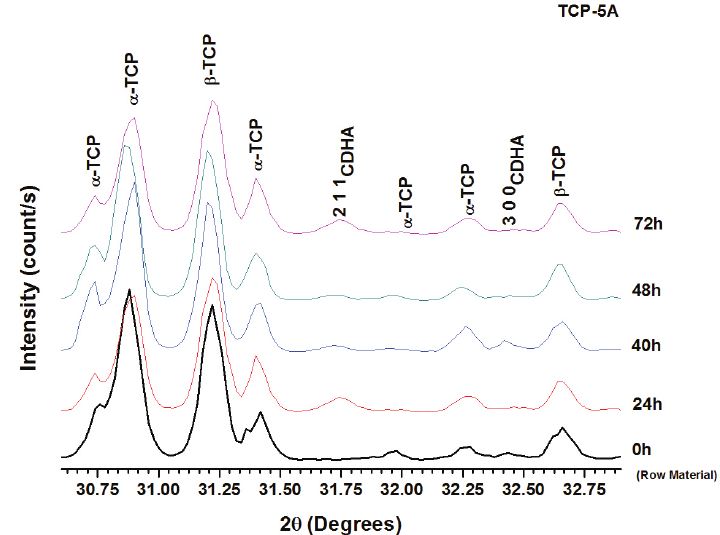
Figure 2. XRD patterns of TCP-5A under in-situ setting condition within 72 hours.